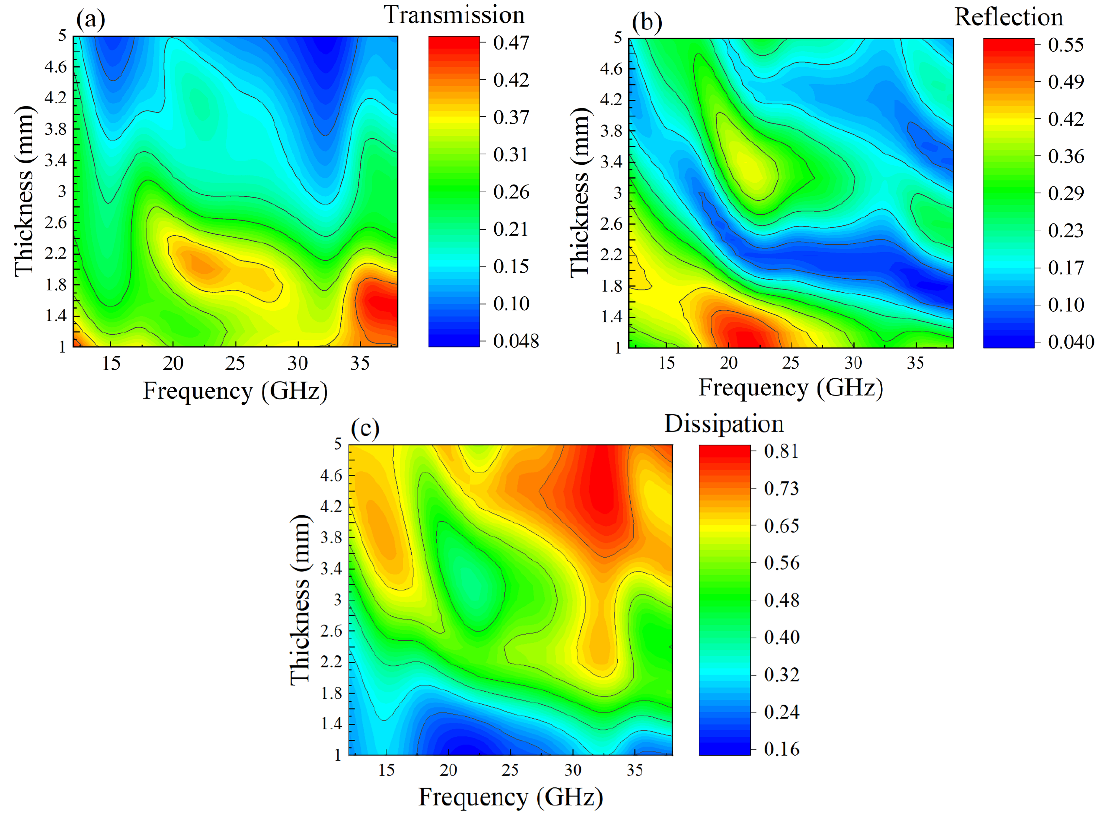
Figure 7. The dependences of transmission coefficient ( a ), reflection coefficient ( b ) and dissipation ( c ) on wave frequency and plate thickness for composite with 15% flakes.